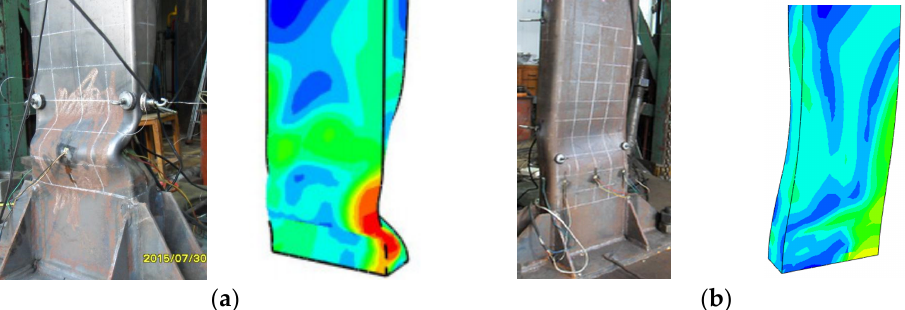
Figure 5. Comparison on failure mode between test and FEA. ( a ) Failure mode of C1-BC-L30-70-02; ( b ) Failure mode of C2-BC-L60-35-02.